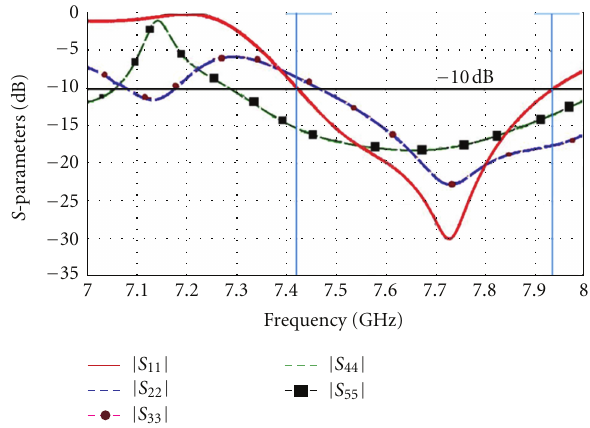
Figure 2: Reflection coe ffi cient magnitudes for the TE 11 , TM 01 , and TE 21 modes excited in the triple-mode